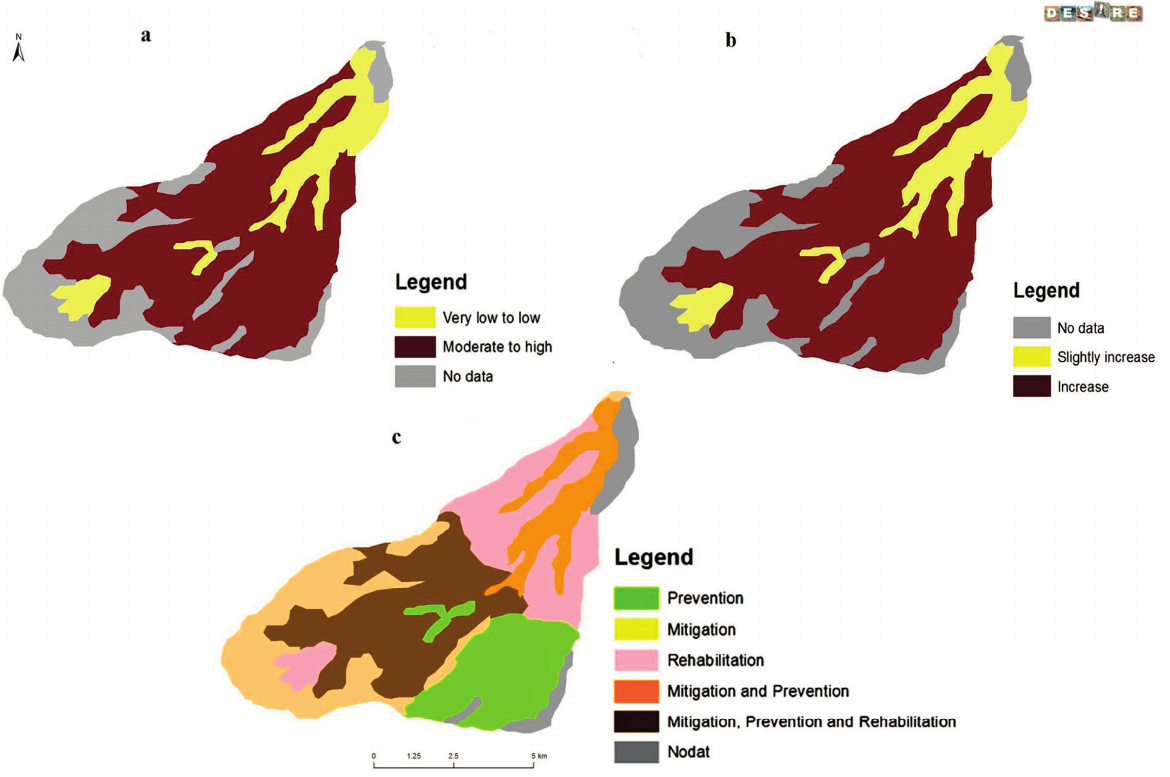
Figure 7. Effectiveness of conservation measures in the Ribeira Seca Watershed, weighted by area, evidencing: ( a ) the moderate to high effectiveness of the implemented measures at slope level, ( b ) the increasing conservation efficiency trend on the slopes and ( c ) expert recommendation on measures. Adapted from